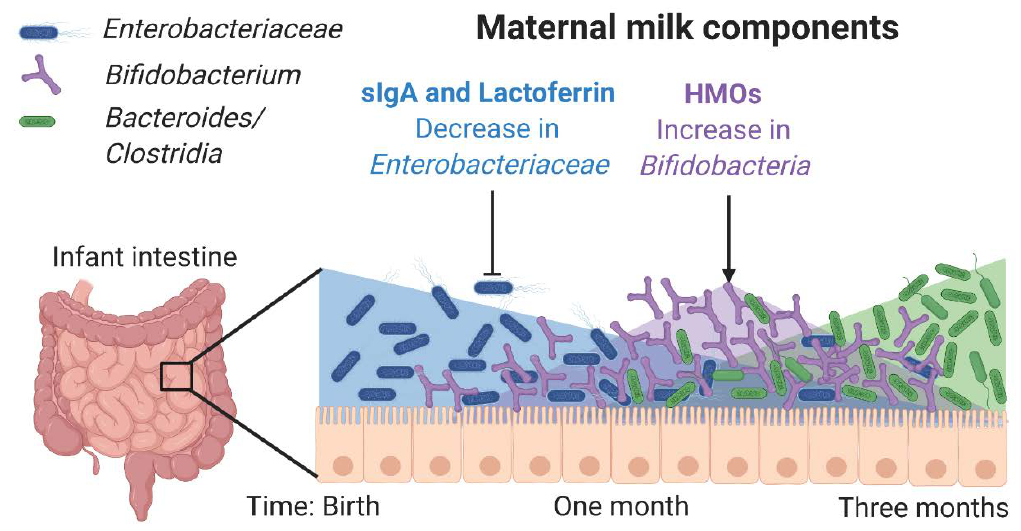
Figure 1. Maternal milk components shape the microbiota. Enterobacteriaceae is one of the first colonizers of the infant intestine and is controlled by secretory IgA (sIgA) from milk, prior to the infant’s own production of sIgA. Lactoferrin inhibits many types of Enterobacteriaceae by binding iron and preventing epithelial adhesion. Human milk oligosaccharides (HMOs) support the outgrowth of Bifidobacteriaceae